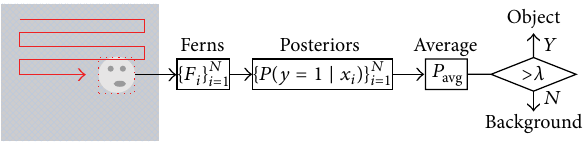
Figure 3: Object detection based on scanning window strategy and randomized forest classifier. The setting of the detector is as follows: 10,000 windows are scanned, 10 ferns per